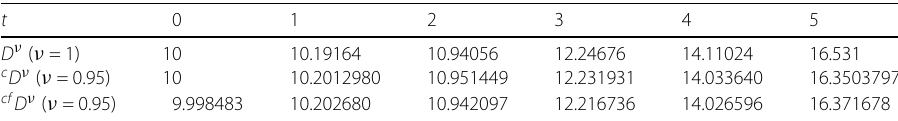
Table 3 Results of three types of derivative: Ordinary derivative D ν , Caputo fractional derivative c D ν , and Caputo–Fabrizio fractional derivative cf D ν for N ( t